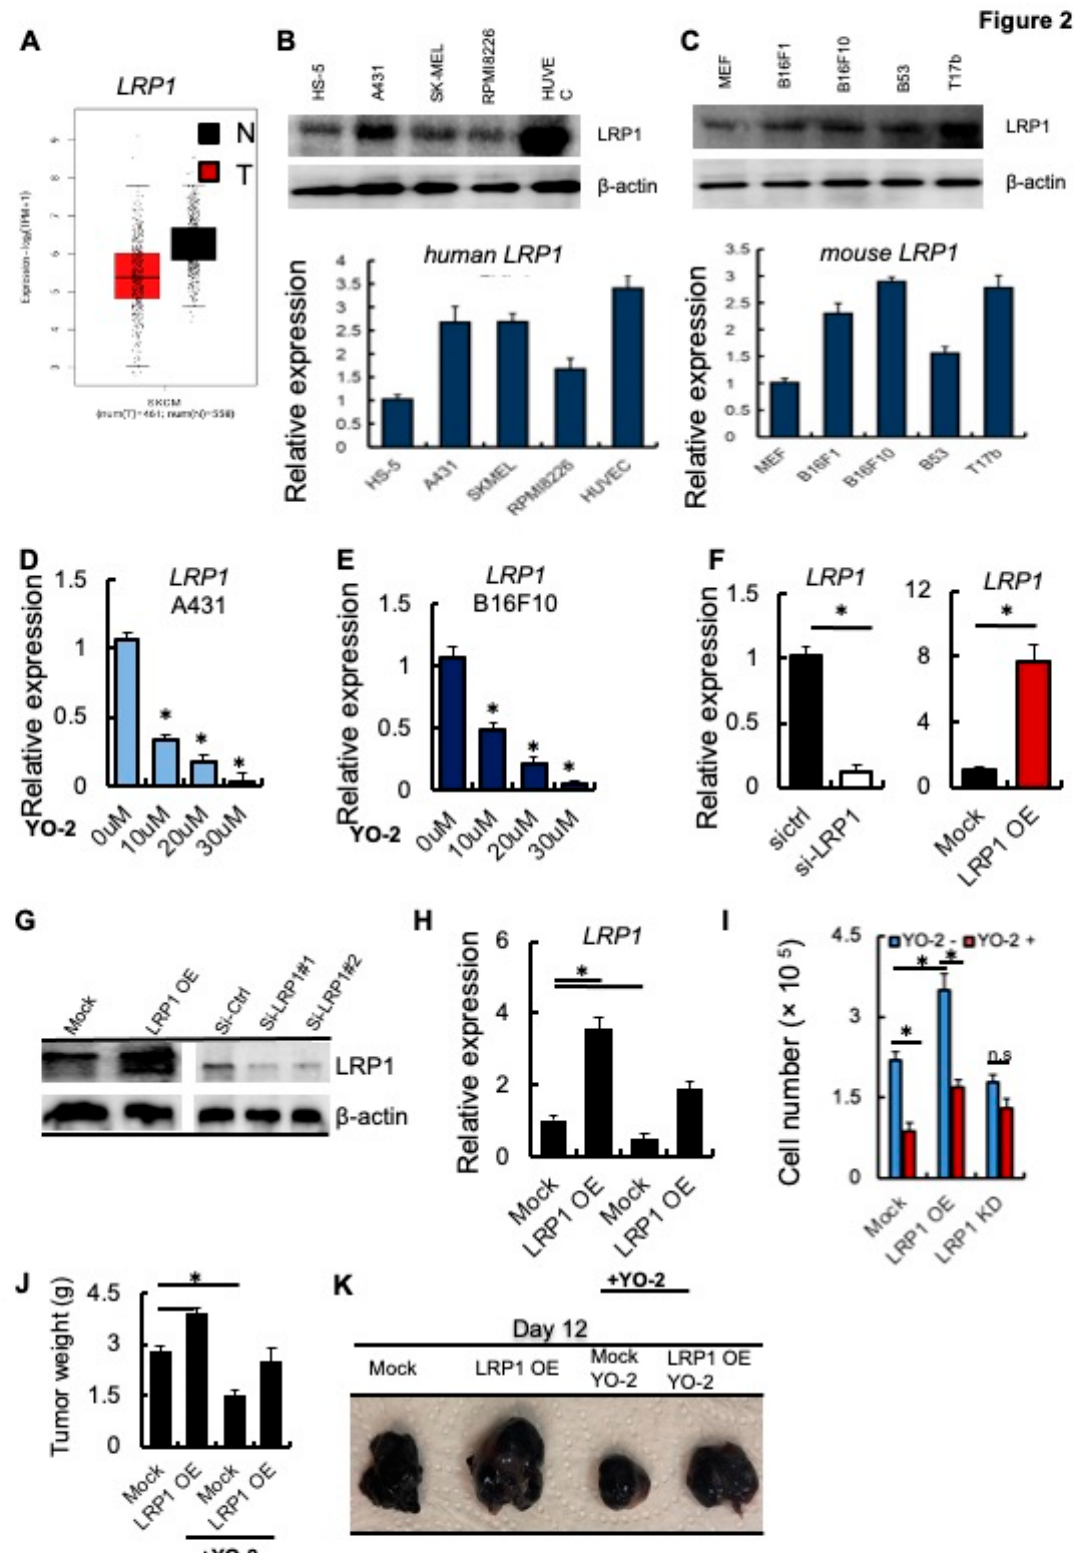
Figure 2. YO ‐ 2 modulates melanoma cell growth through LRP1 downregulation . ( A ) Human LRP1 expression levels in tumors (T) and normal tissues (N) of SKCM patients were retrieved from the TCGA database and analyzed by Timer. ( B , C ) Top panels: Representative immunoblots for LRP1 and b ‐ actin. Bottom panels: Human HS ‐ 5, A ‐ 431, SK ‐ MEL ‐ 28, RPMI8226, HUVEC and murine MEF, B16F1, B16F10, B53, and T17b cells ( C ) were analyzed for LRP1 mRNA expression by qPCR ( n =